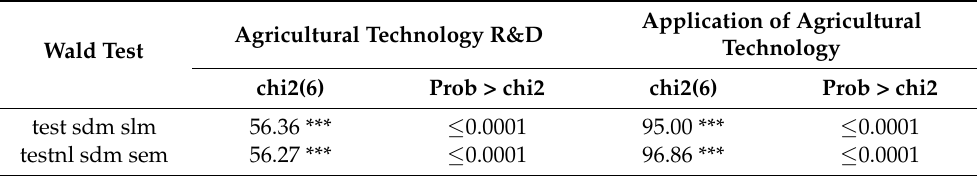
Table 10. Wald test of the regression results of agricultural science and technology innovation and green agricultural development under the economic matrix.